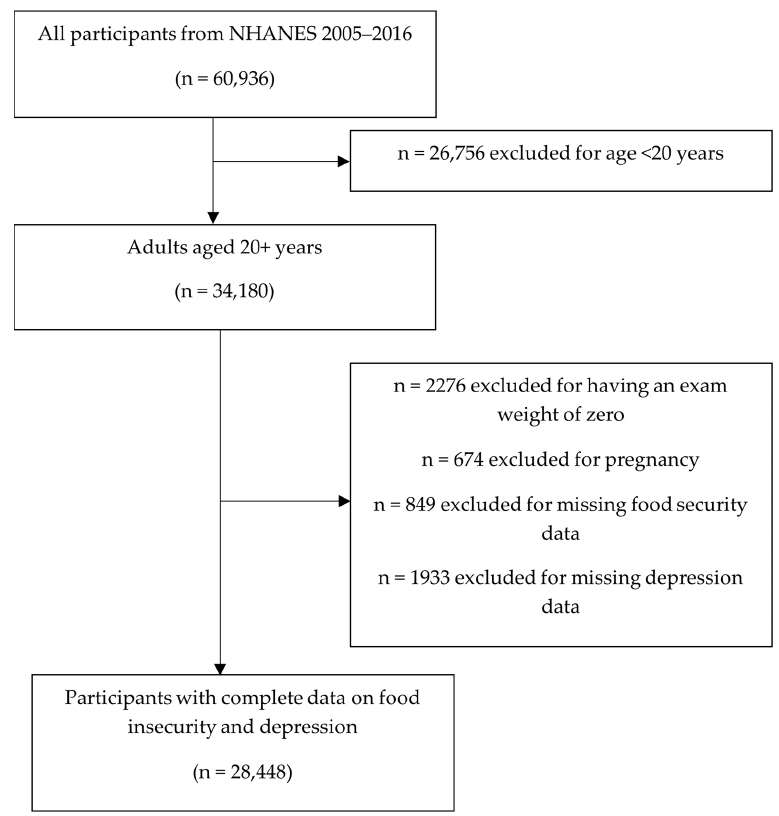
Figure 1. Flow chart of inclusion and exclusion criteria for the study sample.